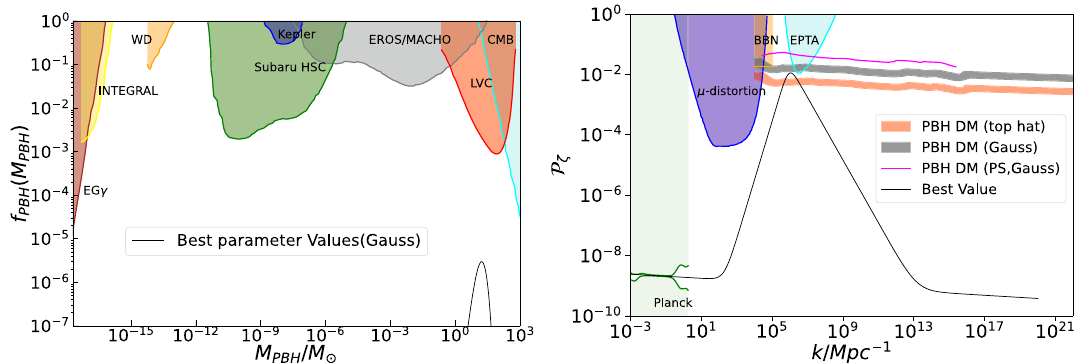
Fig. 2 The left panel shows the observational constraints on the PBHs abundance: the cyan region from accretion constraints by CMB [135,136], the red region from LIGO-Virgo Collaboration measure- ments [137–142], the gray region from the EROS/MACHO [143], the green region from microlensing events with Subaru HSC [144], the blueregionfromtheKeplersatellite[145],theorangeregionfromwhite dwarfexplosion(WD)[146],theyellowregionfromgalacticcenter511 keV gamma-ray line (INTEGRAL) [147–149], and the brown region from extragalactic gamma-rays by PBH evaporation (EG γ ) [150]. The right panel shows the constraints on the primordial curvature spectrum.